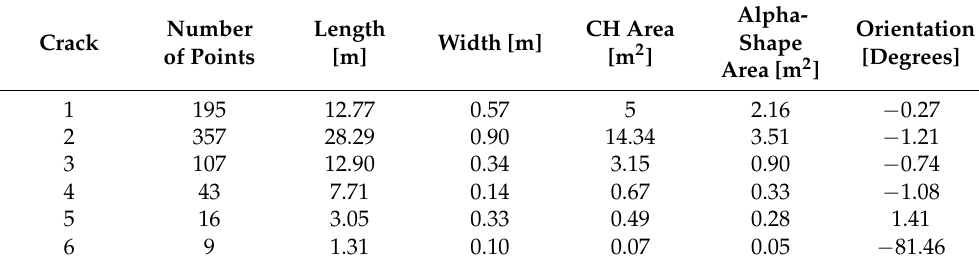
Table 3. Road spot 1. Geometric parameters of cracks detected with the proposed